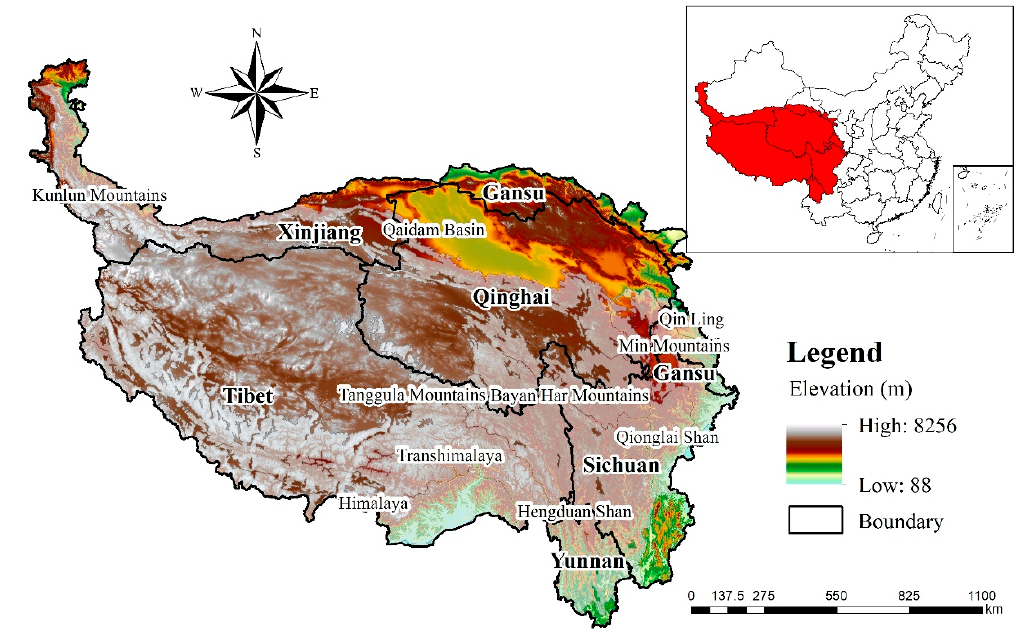
Figure 1. Location and main mountains of the Qinghai-Tibet Plateau.